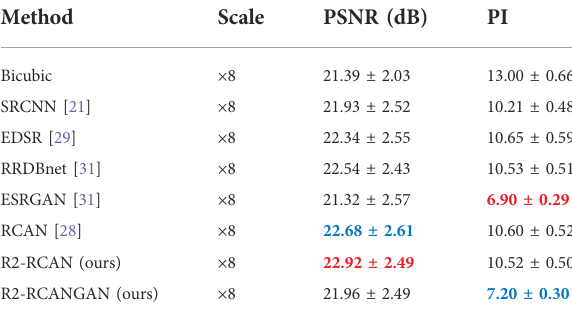
TABLE 1 Quantitative results of different methods on the test set (PSNR/PI). Red and blue indicate the best and the second best performance,